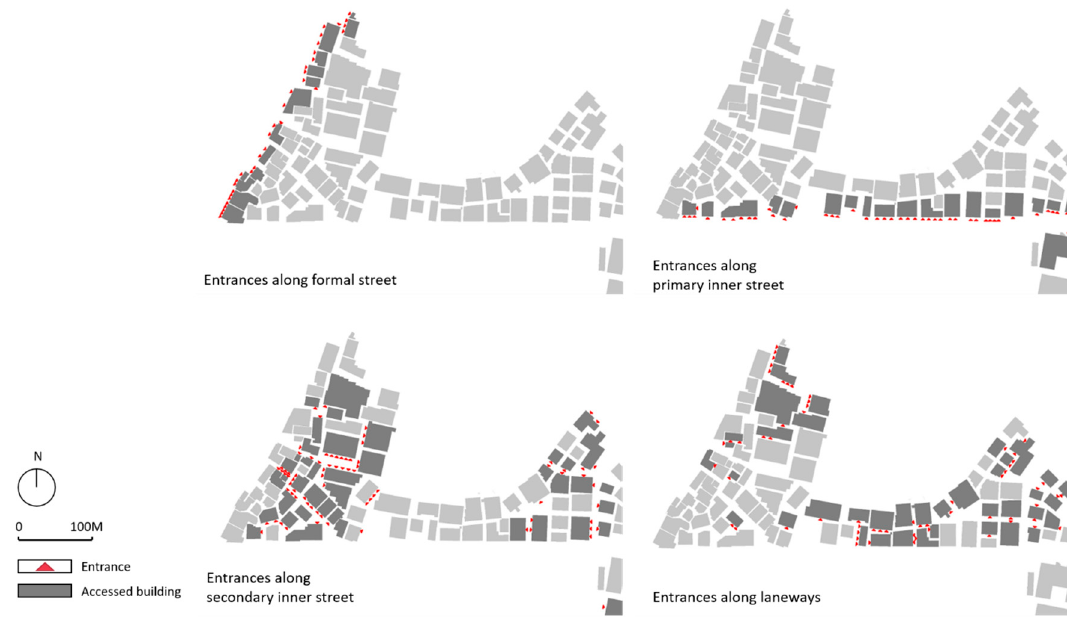
ff erent types of